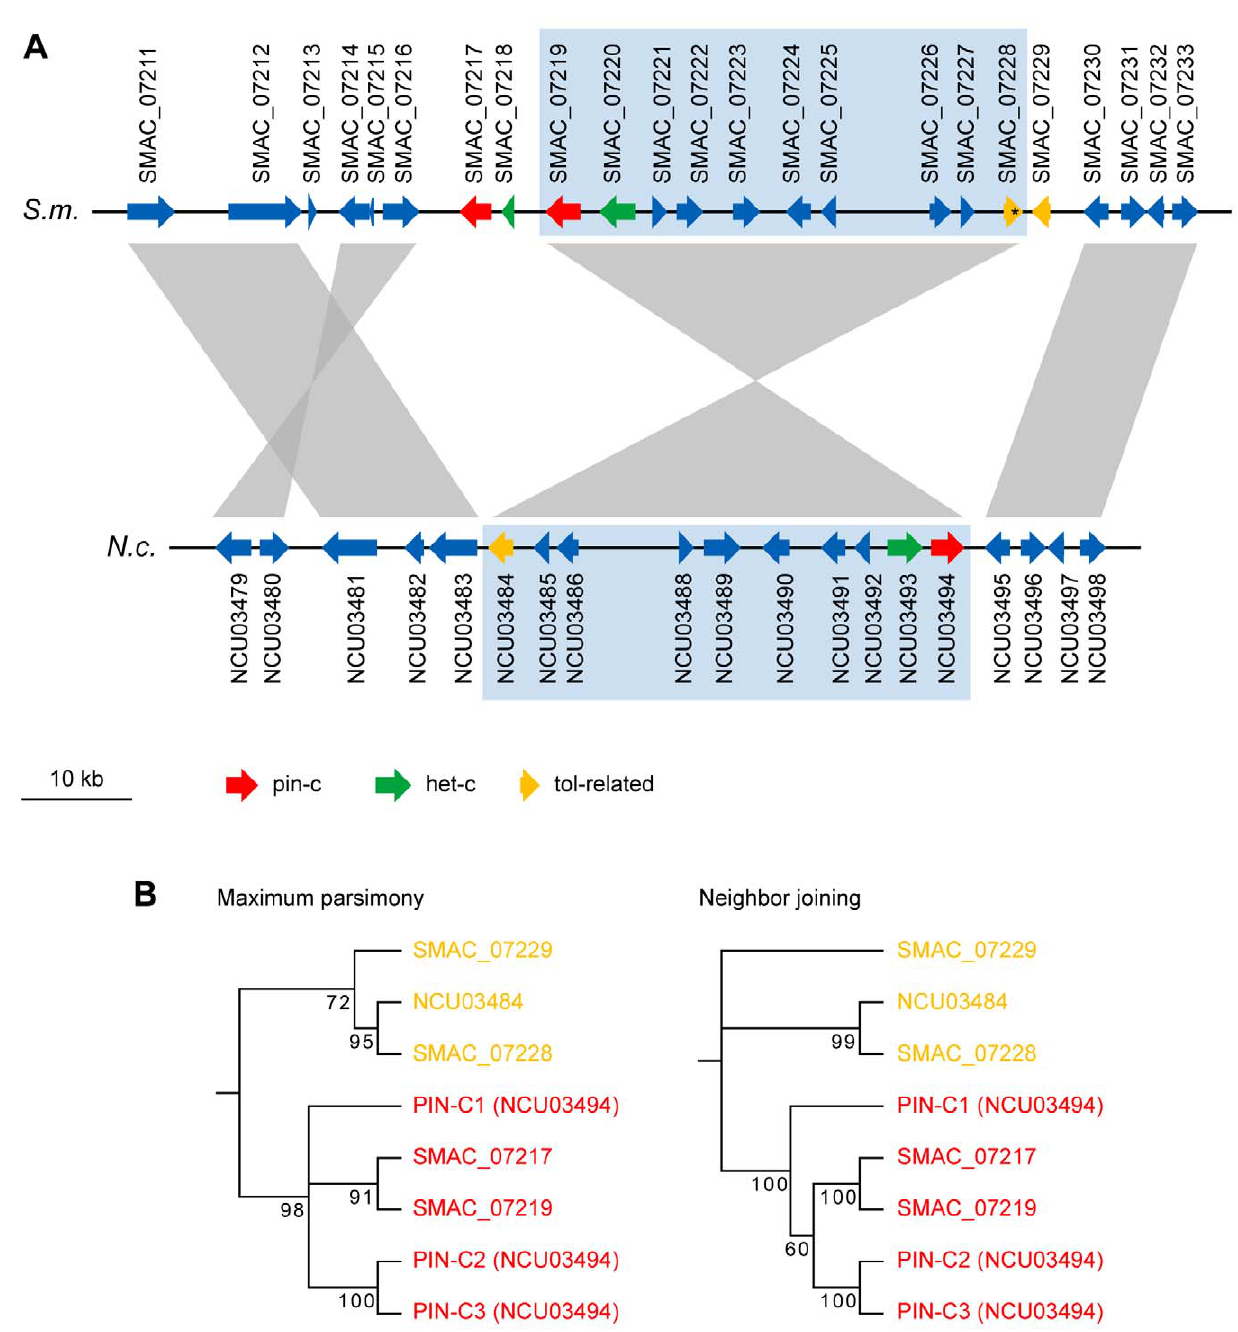
Figure 5. The het-c / pin-c locus of S.macrospora contains additional copies of putative heterokaryon incompatibility genes. (A) Region from S. macrospora scaffold 98 and N. crassa contig 8 containing het-c and pin-c genes. A syntenic region containing the N. crassa het-c and pin-c genes and the orthologous region in S. macrospora is shaded in blue. In S. macrospora , this region is bordered by additional copies of pin-c and a partial het-c (left) and a TOL-related protein encoding gene (right). The tol -related gene SMAC_07228 contains an internal stop codon within the open reading frame (indicated by an asterisk) and therefore encodes a shortened TOL-related protein or is a pseudogene. (B) Phylogenetic tree of PIN-C and TOL-related proteins from the genomic region shown in (A). For N. crassa , three allelic variations of PIN-C (PIN-C1, PIN-C2, and PIN-C3) were used for tree construction. The PIN-C1 protein from Pyrenophora tritici-repentis was used as an outgroup to root the tree. Maximum parsimony and neighbor joining trees were calculated with 10,000 bootstrap replications each. The phylogenetic tree separates the PIN-C and TOL-related proteins, however, it is not conclusive with respect to the putative ancestral state of the PIN-C alleles. doi:10.1371/journal.pgen.1000891.g005 SMAC_01188 and SMAC_01198 , are organized in a cluster of during sexual development. The three pks genes that are not upregulated comprise the single type III pks gene as well as two pks putative polyketide biosynthesis genes (Figure 8). Despite the fact genes without orthologs in N. crassa . These two pks genes, that polyketide biosynthesis genes are often clustered in filamen-